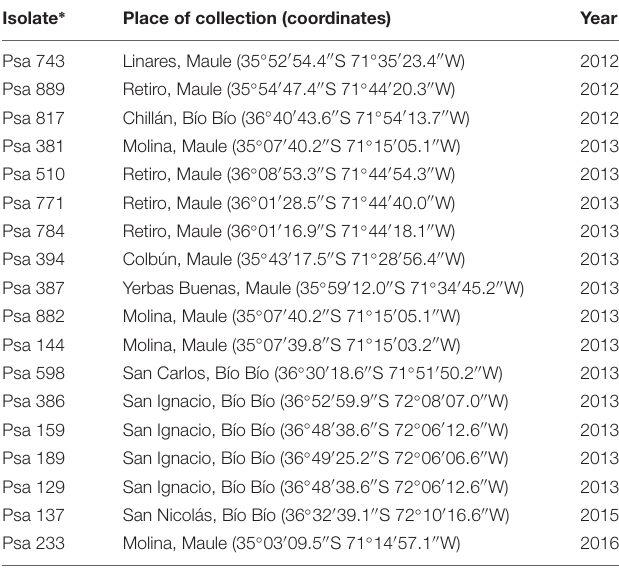
TABLE 1 | Chilean Psa isolates used in this